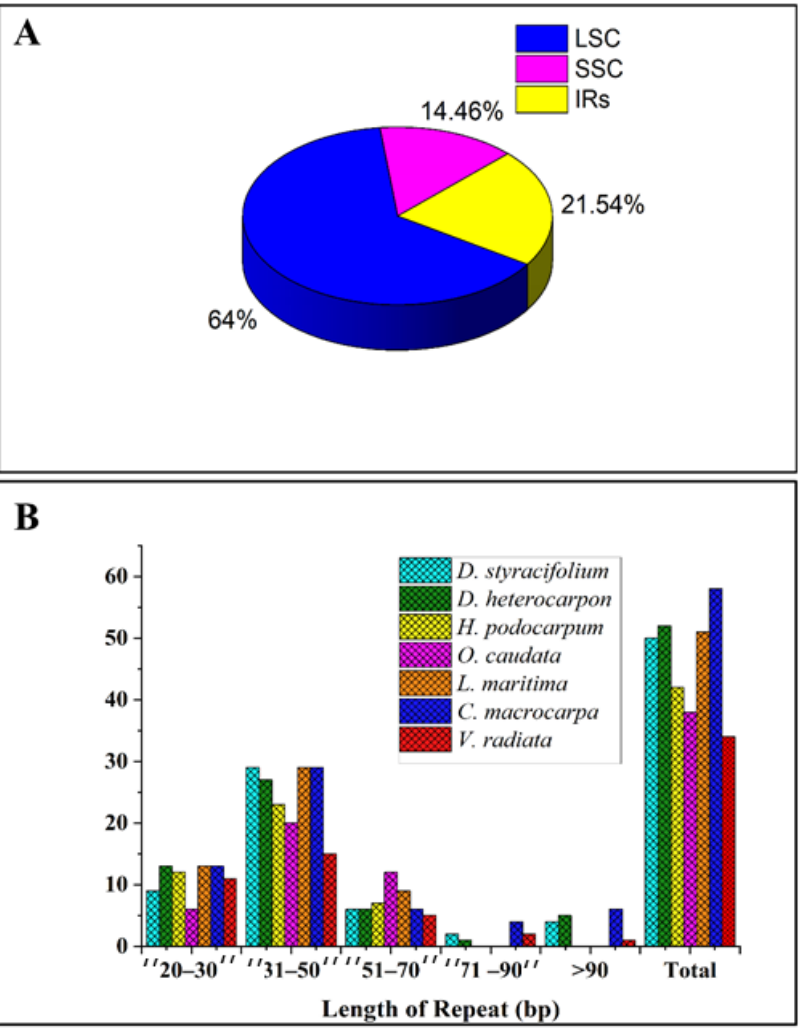
Figure 5. Tandem repeat analysis among seven studied species. ( A ) Percentage distribution of all tandem repeats based on the quadripartite structure. ( B ) Frequency of tandem repeats by length .